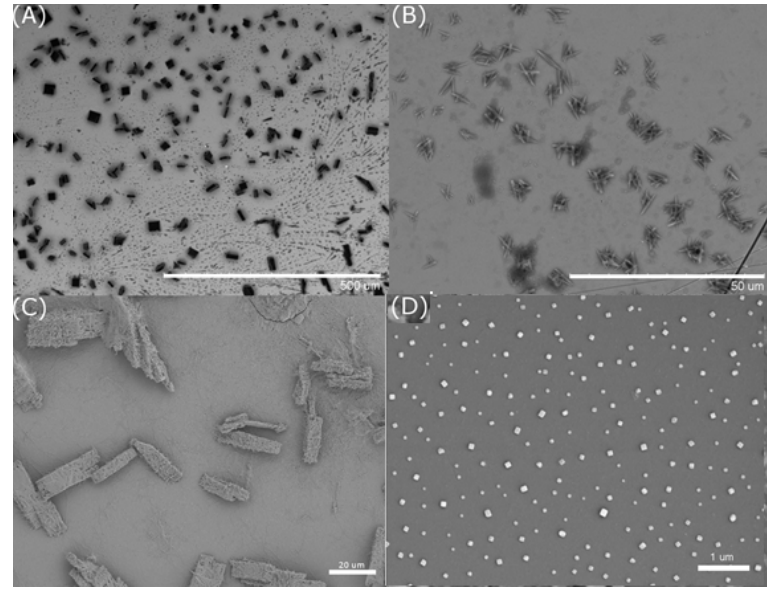
Figure 2. Formation of metal-organic frameworks (MOF) structures of Cu(BTC)·3H 2 O. ( A ) 100 µL of both 30 mM CuSO 4 ·5H 2 O and 30 mM BTC in methanolic solutions